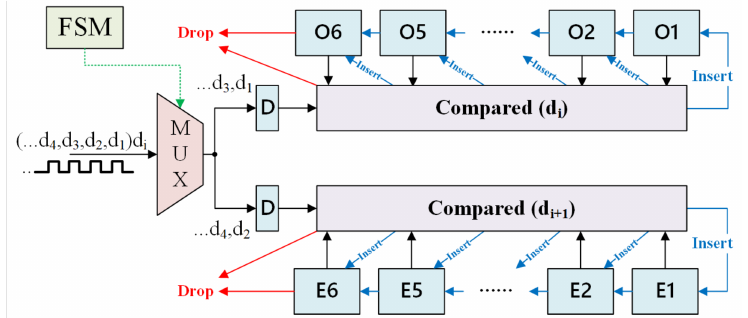
Figure 8. Block diagram of SNLF.